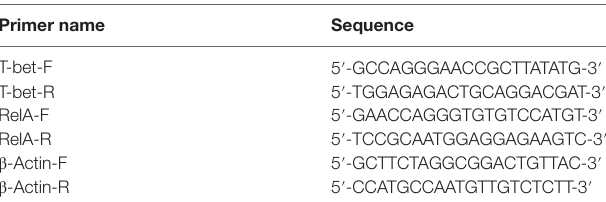
TaBle 2 | Sequences of primers used for amplification of p65/RelA, T-bet, and β -actin